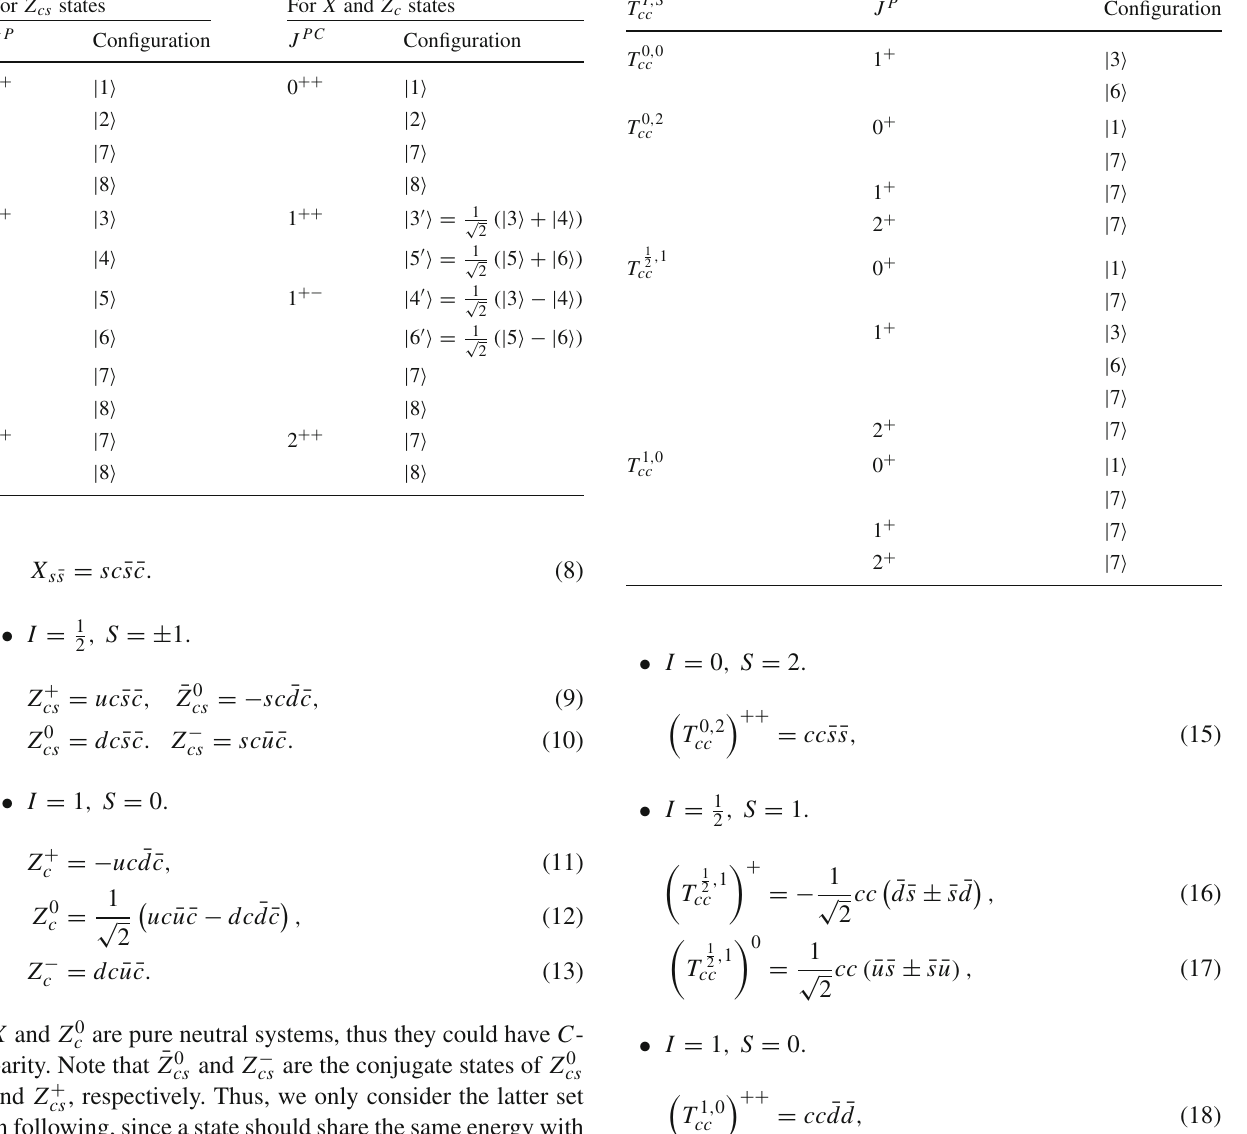
Table 4 The symmetry configurations of double-charm systems T I , S cc J P